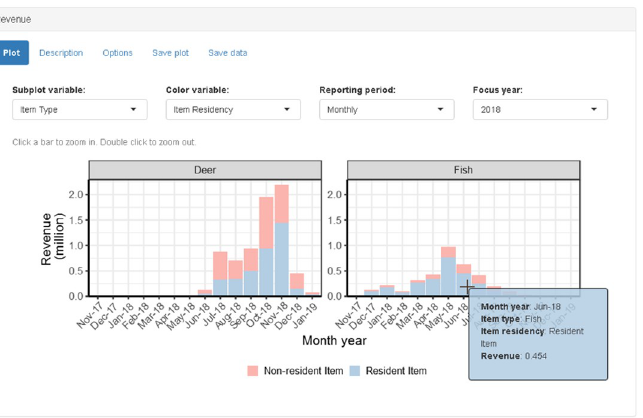
Fig 3. Screenshot of revenue panel when “item type” is selected as subplot variable, “item residency” is selected as color variable, and “monthly” is selected as reporting period. For simplicity, only two item types are shown; additional rows are added automatically to accommodate any number of subplots. The plot includes permits issued in 2016 prior to the start of the 2017 permit year and late season permits issued in